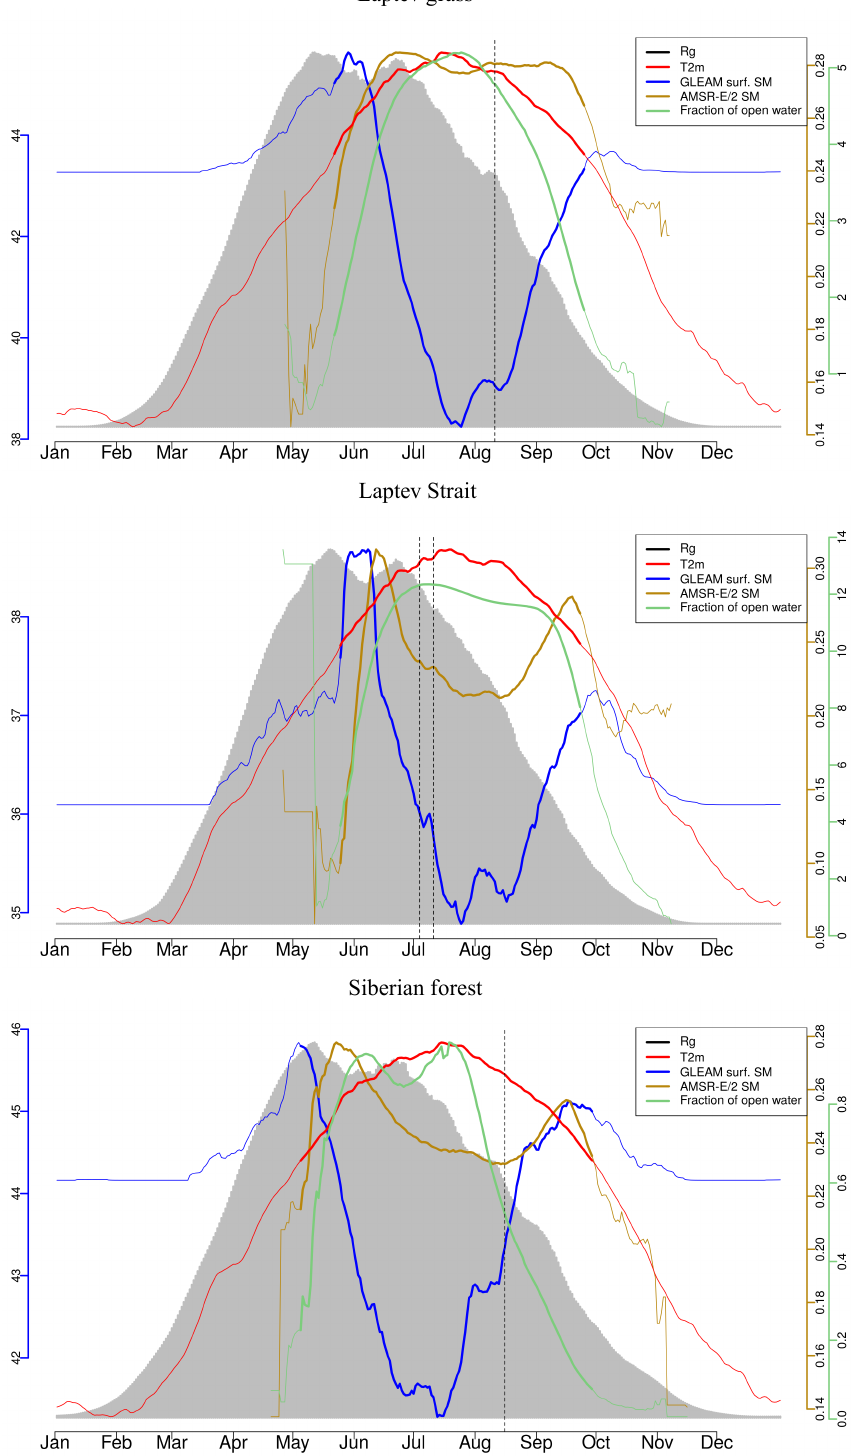
Figure A2. Climatologies of different atmospheric and land surface variables for different small area indicated in Fig. 1. Bold lines indicate the time period when air temperatures are above the freezing point (no axes displayed for temperature and incoming